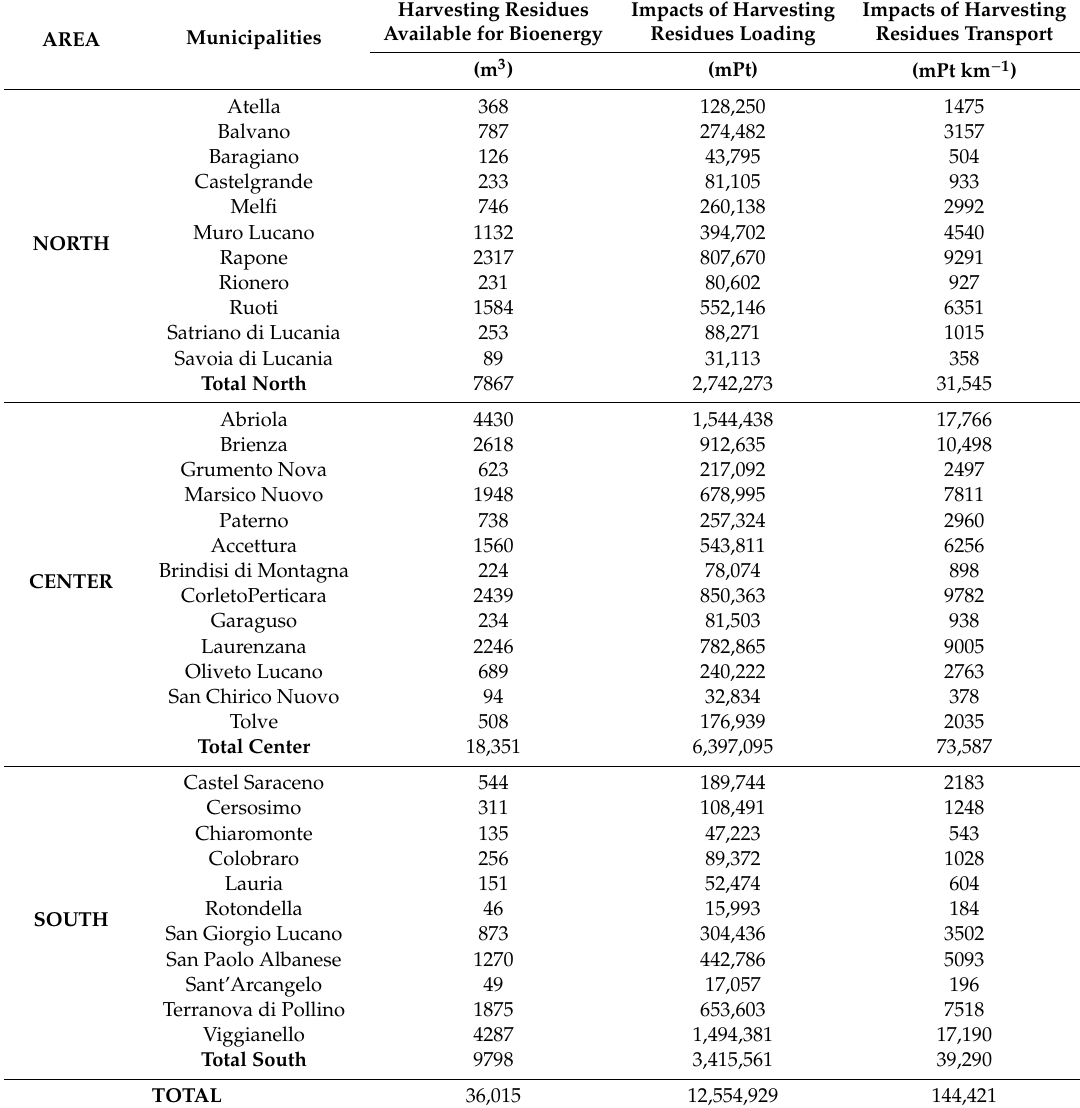
Table 1. Harvesting residues available for bioenergy production and environmental impacts per studied